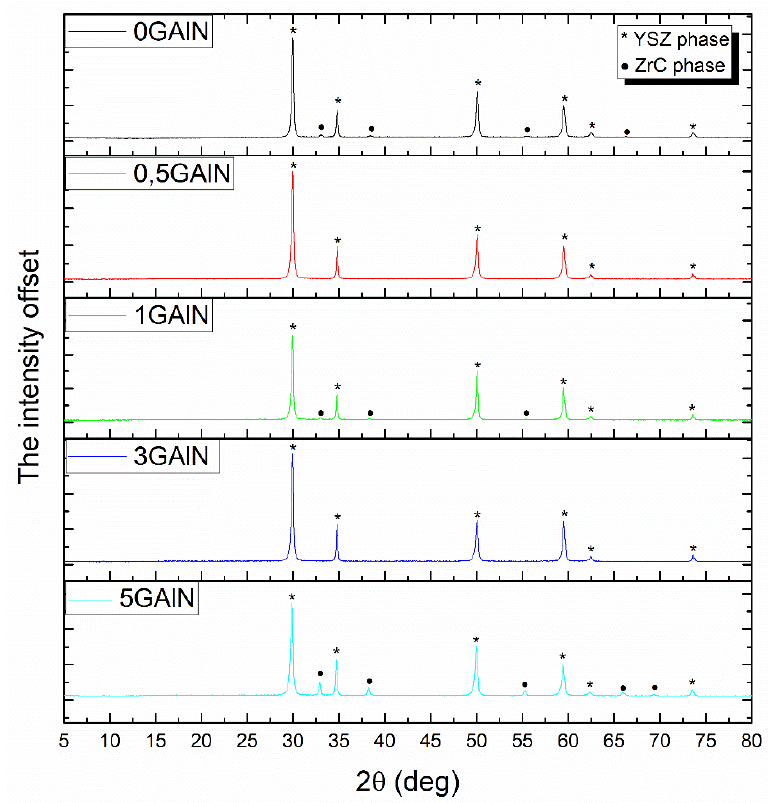
Figure 2. XRD patterns of obtained YSZ-GAlN composites.